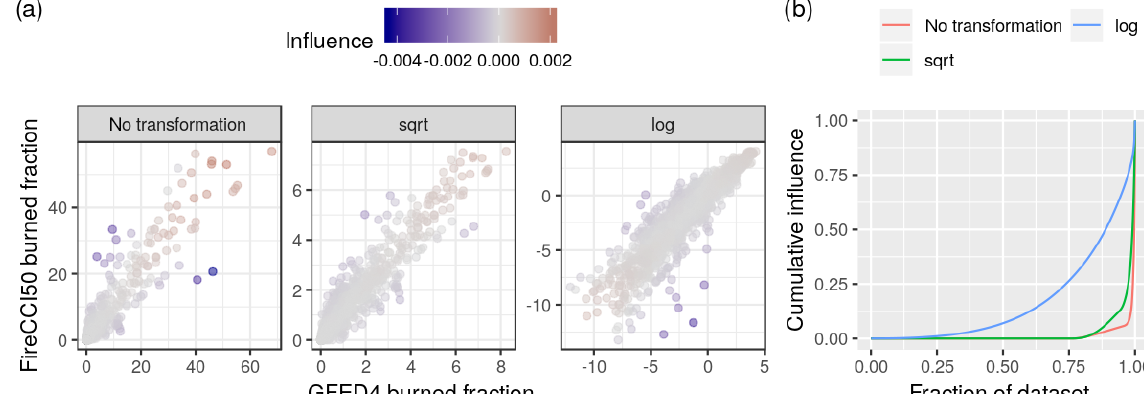
Figure A9. Scatter plots for the GFED4 and FireCCI50 dataset without transformation, square root transformation and log transformation (a) . The colour indicates the influence of individual datapoints on the correlation (computed as the difference in the correlation with and without that datapoint). Cumulative influence of datapoints in the dataset on the correlation (b) . Without transformation a very small fraction has a strong influence on the correlation; these are grid cells with high burned area fraction (as can be seen in a ).